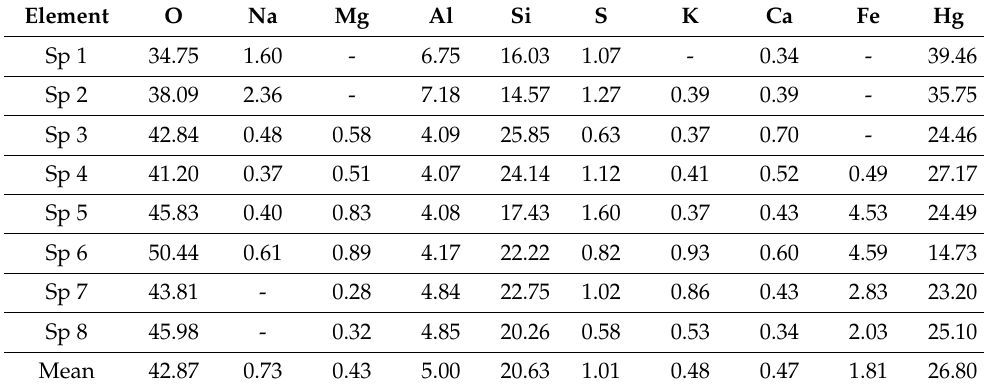
Table 8. Semi-quantitative chemical composition (given in wt%) of the eight analyzed fields on the SZHg sample (spectra, Sp; analyzed with EDS).